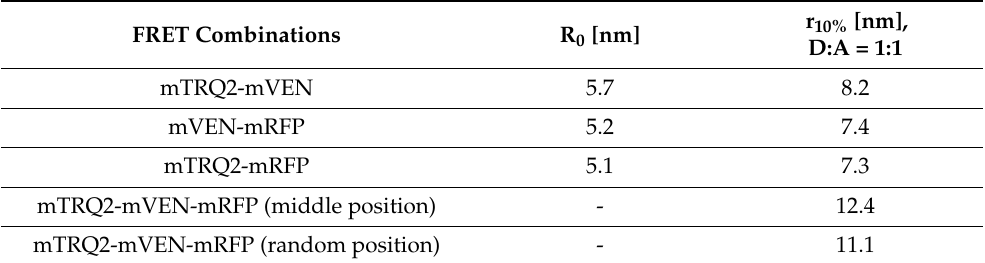
Table 1. FRET combinations (1st column), their Förster distances (R 0 ) (2nd column) and fluorophore distances that correspond to 10% FRET efficiency (r 10% ), calculated for a linear arrangement with one acceptor (3rd column) in range of each corresponding donor (see also Supplemental Table